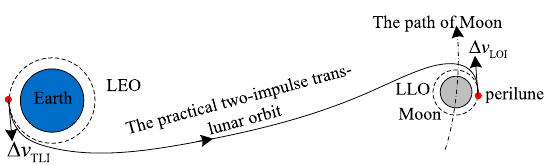
Fig. 1 Illustration of the practical two‑impulse trans‑lunar